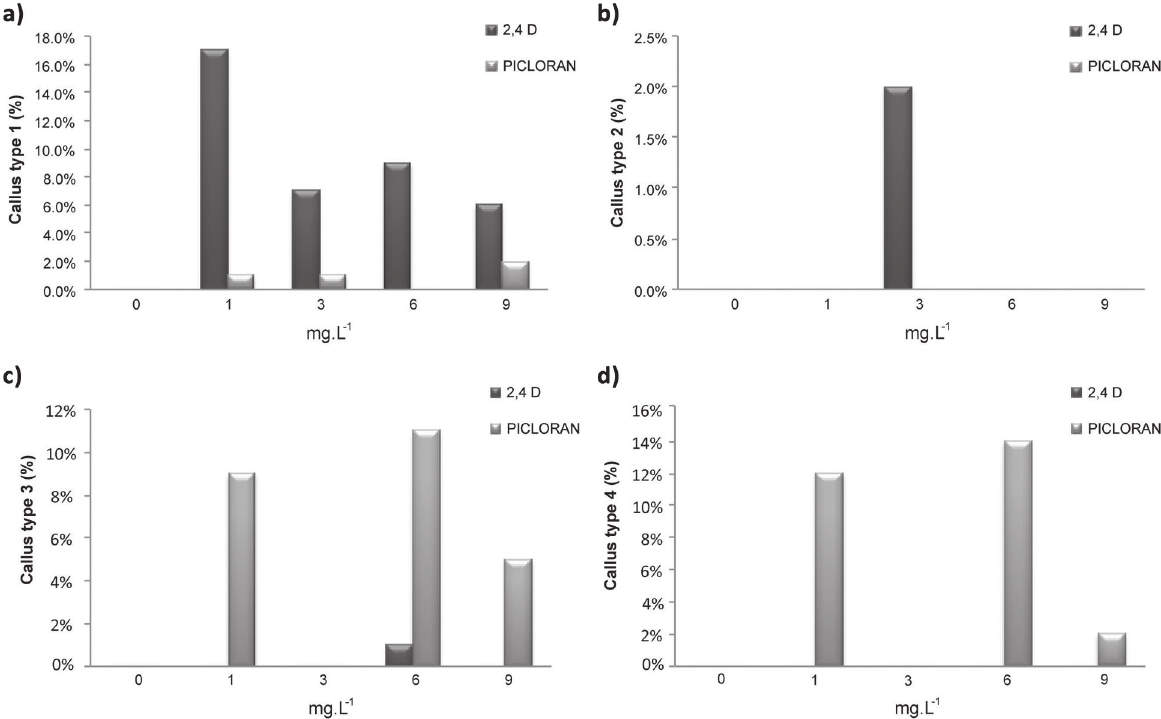
Figure 3 - Callus type percentage of oil palm tenera hybrid ( Elaeis guineensis ) induced on different 2,4D and picloran. A) Type 1, B) Type 2, C) Type 3, and D) Type